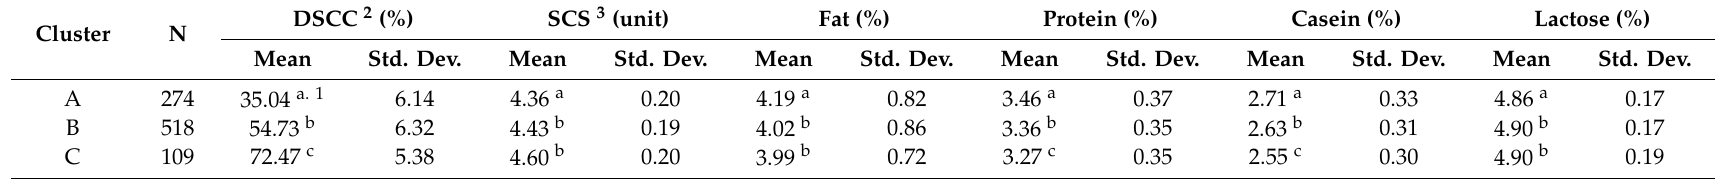
Table 7. Comparison of milk component means among the three clusters defined by agglomerative hierarchical